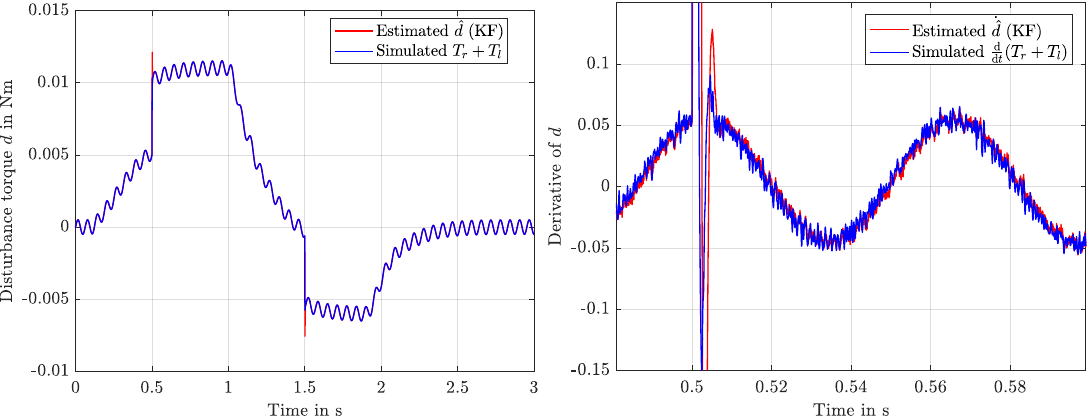
Figure 9. d ( t ) , ˙ d ( t ) and their estimates provided by the KF.